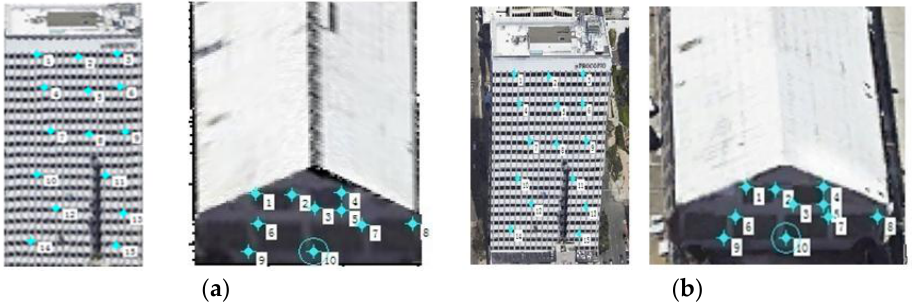
Figure 17. Selected points for accuracy verification. ( a ) Testing points of the two buildings; ( b ) standard points selected from Google-Earth.